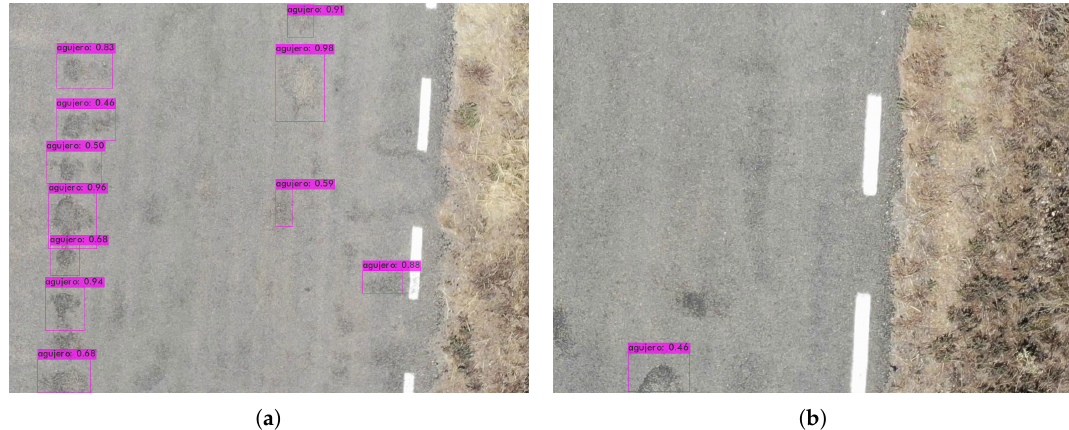
Figure 10. Detection results in a large number of potholes. ( a ) Multiple detection. ( b ) Single pothole.